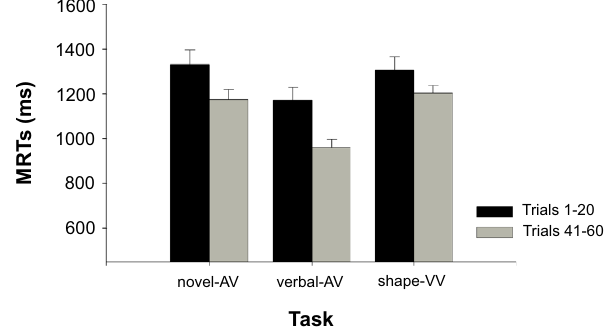
Figure 5. Reaction times for associative learning tasks. Average motor reaction times (MRTs) ( ± SEM) for the learning phase (Trials 1-20) and the learnt phase (Trials 41-60) in the novel-sound auditory visual (novel-AV), verbal-visual (verbal-AV), and visual-visual (shape-AV) learning